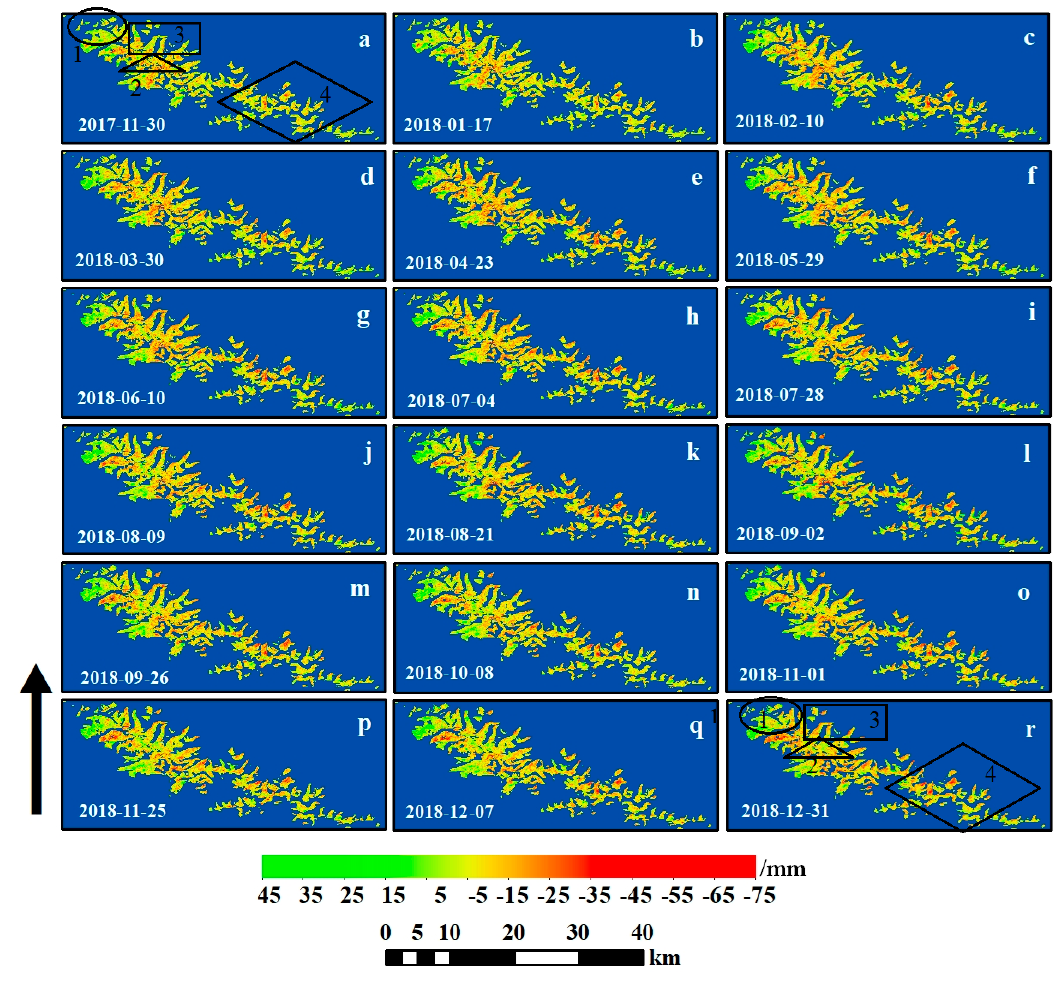
Figure 6. (a-r) Time series of calculated glacier deformations relative to 18 November 2017 from 30 November 2017 to 31 December 2018. Positive and negative values represent movement towards and away from the satellite along the LOS, respectively. The black arrow represents the LOS direction, which is from satellite to the ground, meanwhile from south to north.